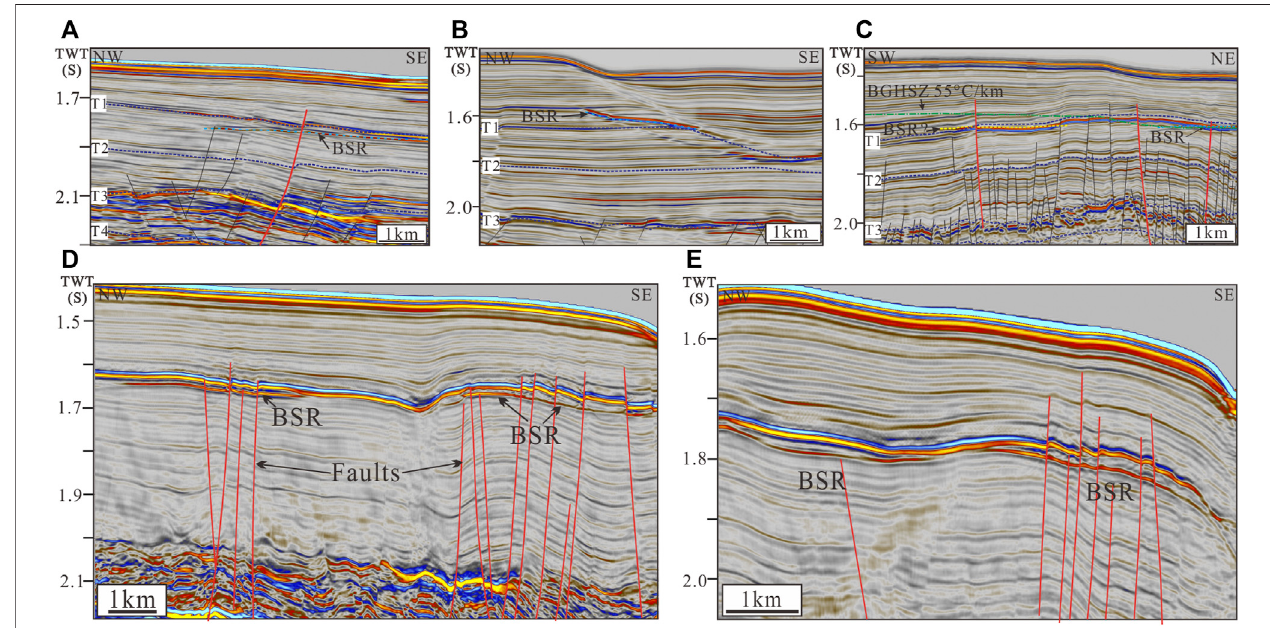
FIGURE 3 | (A) – (E) The seismic characteristics of BSR and high amplitude anomalies at different locations and their relationship with faults, pockmarks, and the base of the gas hydrate stability zone calculated from 55 ° C/km (location shown in Figure 1B